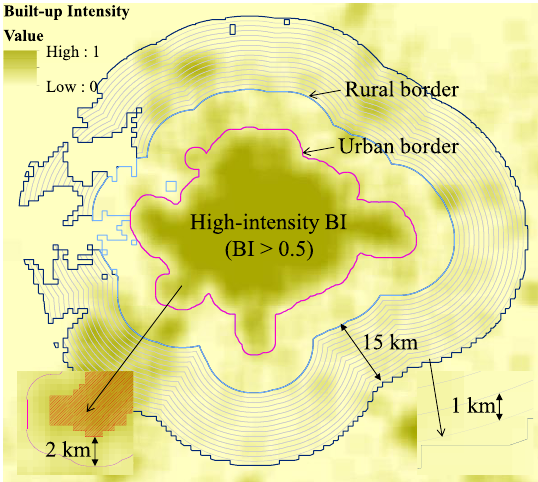
Figure 2. A schematic map shows the way of regional division.